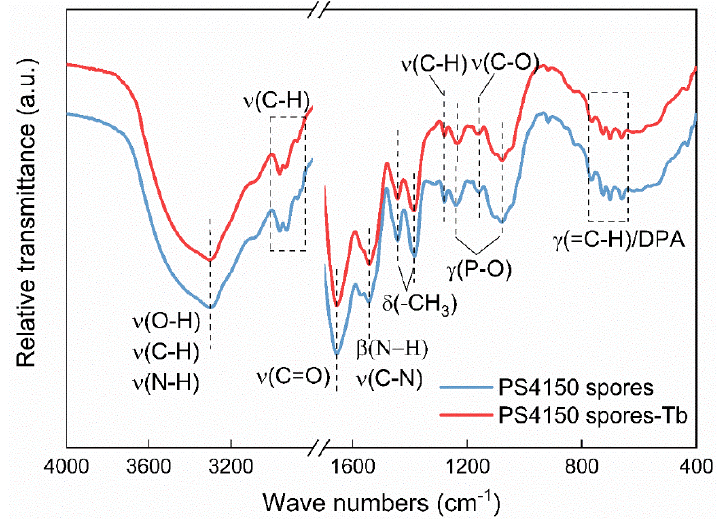
Figure 7. FTIR spectrum of spores before and after adsorption of Tb(III).